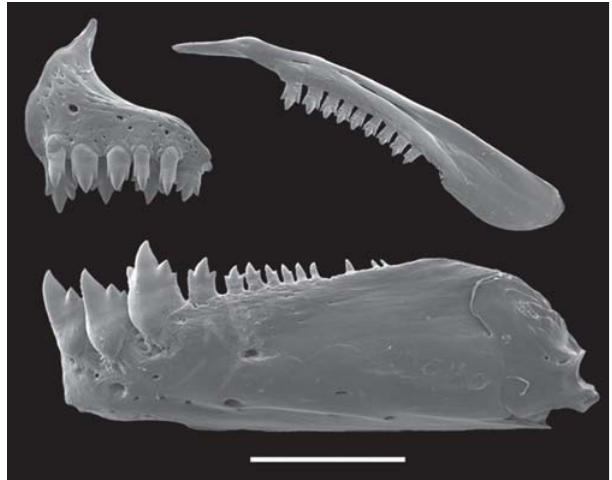
Fig. 17. Hemibrycon mikrostiktos , MCP 44521, paratype, female, 35.7 mm SL. Scanning electron micrograph of left side upper and lower jaws. Scale bar = 1